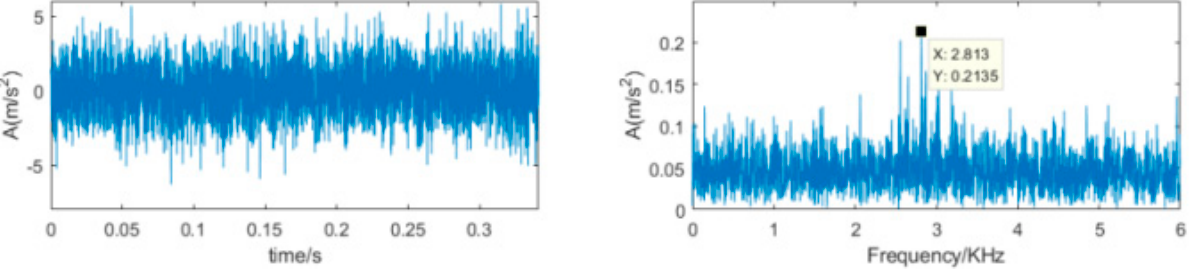
Figure 12. Time-domain waveform and frequency spectrum of the vibration signal with strong noise. To use the proposed SVD-VMD method, we construct Hankel matrix and decompose the matrix by SVD, then calculate the difference spectrum of singular which is shown in Figure 13. According to the difference spectrum, we find the maximum mutation position, from which we can determine the effective order of singular values. In Figure 13, there are four peaks and the maximum peak is at the index of eight which is larger than the other